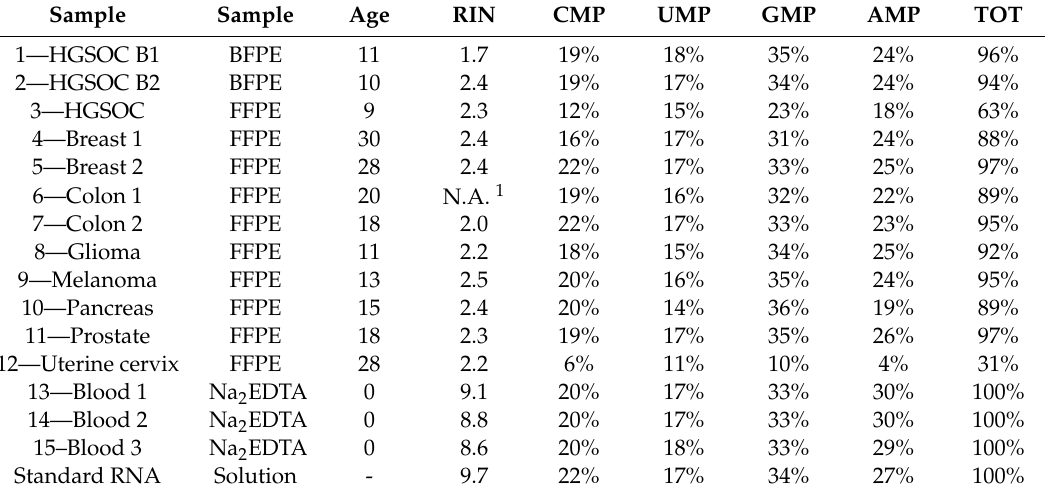
Table 7. Results of HPLC analysis as area percentage of canonical NMPs and integrity of clinical samples. Samples’ age is reported in